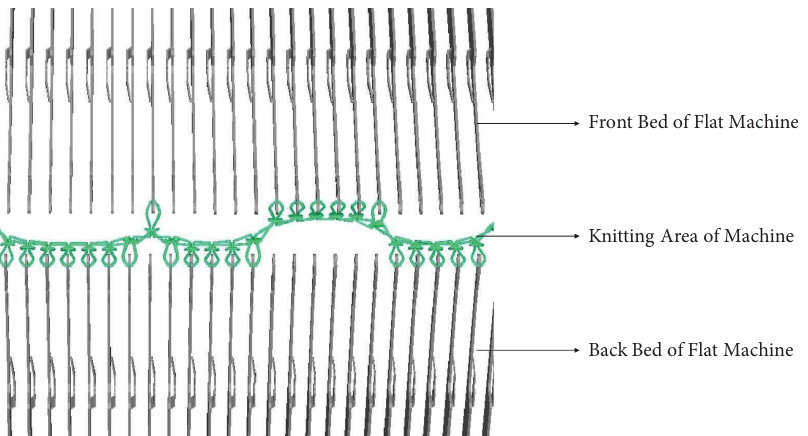
Figure 4: Animated view of auxetic fabric production using apex III.